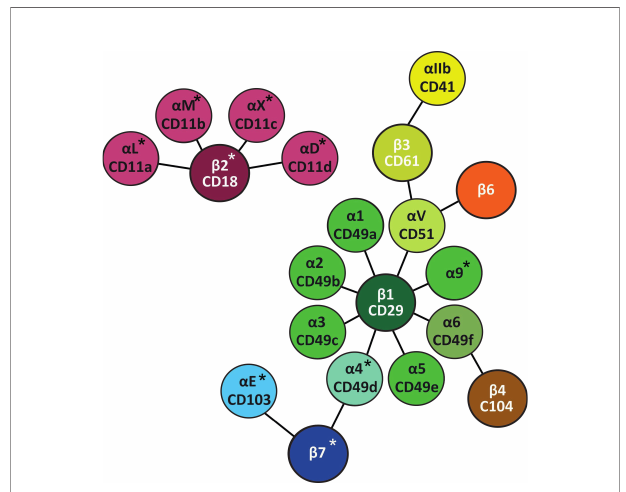
FIGURE 2 | Leukocyte integrins. Leukocyte integrins arranged around their b chains. a and b chains marked with * are speci fi c for leukocytes (27), while platelets also express b 2-integrins